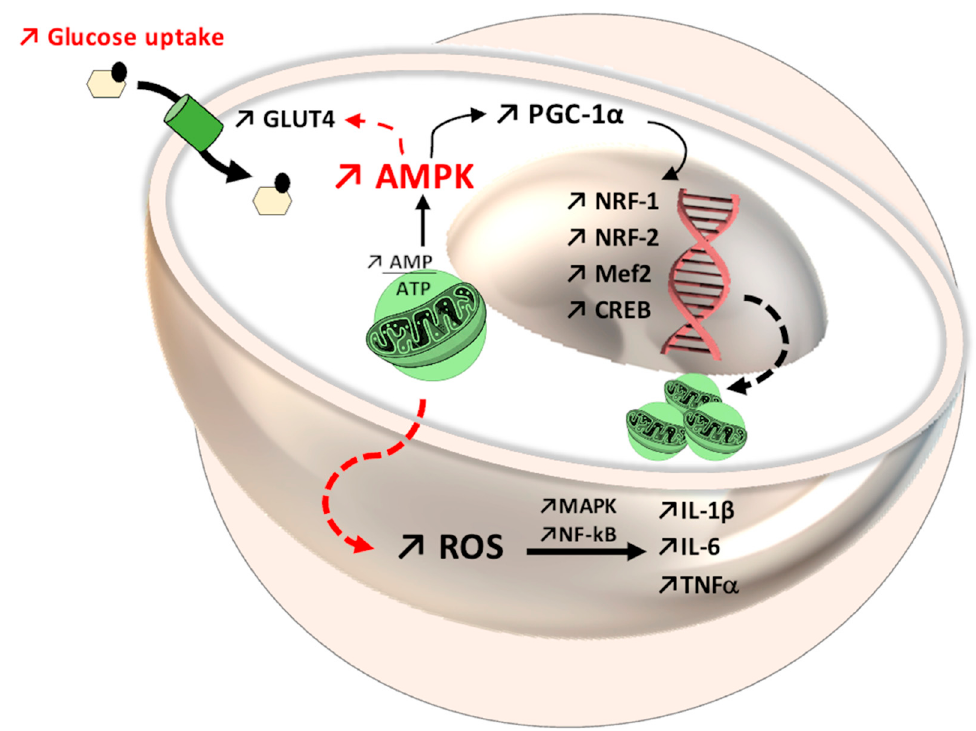
Figure 5. Mitochondrial dynamics through the 5 ′ adenosine monophosphate-activated protein kinase-peroxisome proliferator-activated receptor gamma coactivator 1-alpha (AMPK-PGC-1 α ) system, with increased expression of nuclear factor erythroid 1-related factor (Nrf-1), nuclear factor erythroid 1-related factor (Nrf-2), myocyte enhancer factor-2 (Mef2), and cAMP response element-binding protein (CREB). At the same time, in the AMPK pathway, an improvement in glycemic status can be observed, through translocation of glucose transporter GLUT4 in the cellular membrane. Regarding the immune system, reactive oxygen species (ROS) enhance the activity of mitogen-activated protein kinase (MAPK) and nuclear Factor kappa B (NF-kB), which further favors interleukin and cytokine secretion (IL-1 β , IL-6, tumor necrosis factor, TNF).